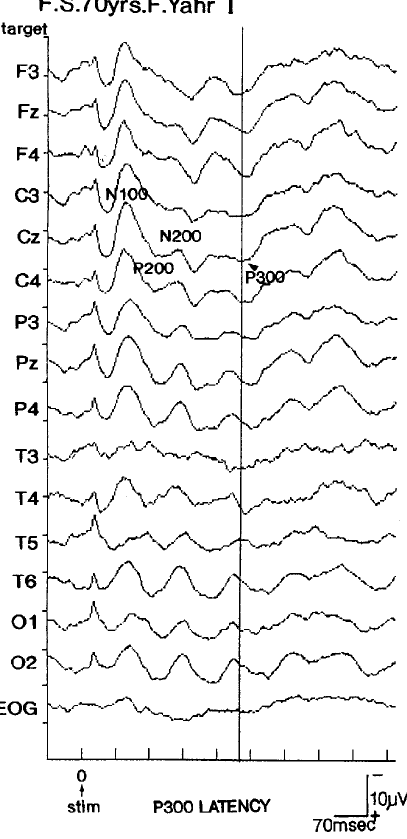
Fig. 1. ERP recording in a 70-year-old female with Parkinson’s disease. The peak latency of P300 is within normal